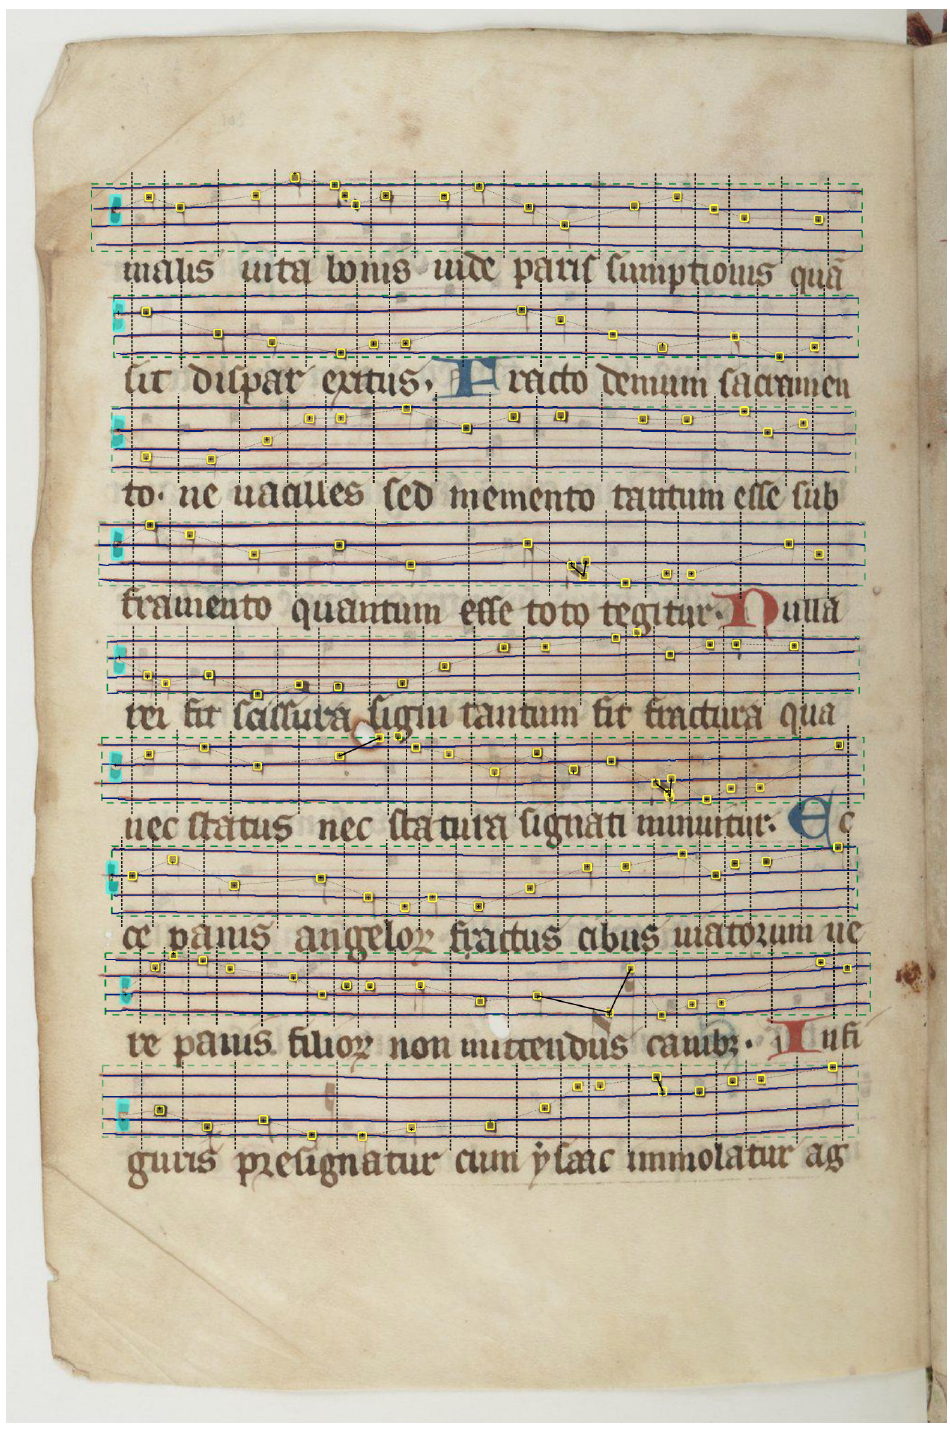
Figure 13. The page visualises the full prediction of the staff line and symbol detection. Encoded staff lines are drawn as blue lines on top of the red staff lines of the original manuscript, the green dashed lines mark the bounding boxes of single staves. The vertical dashed lines separate neumes whose NCs are drawn as yellow boxes. Graphical connection withing a neume are indicated by a black stroke between two NCs. The reading order is represented by a thin dotted line that connects all NCs withing a staff. Small crosses inside of the yellow box of a NCs mark the discrete location of the symbol relative to the staff lines. The cyan symbols mark